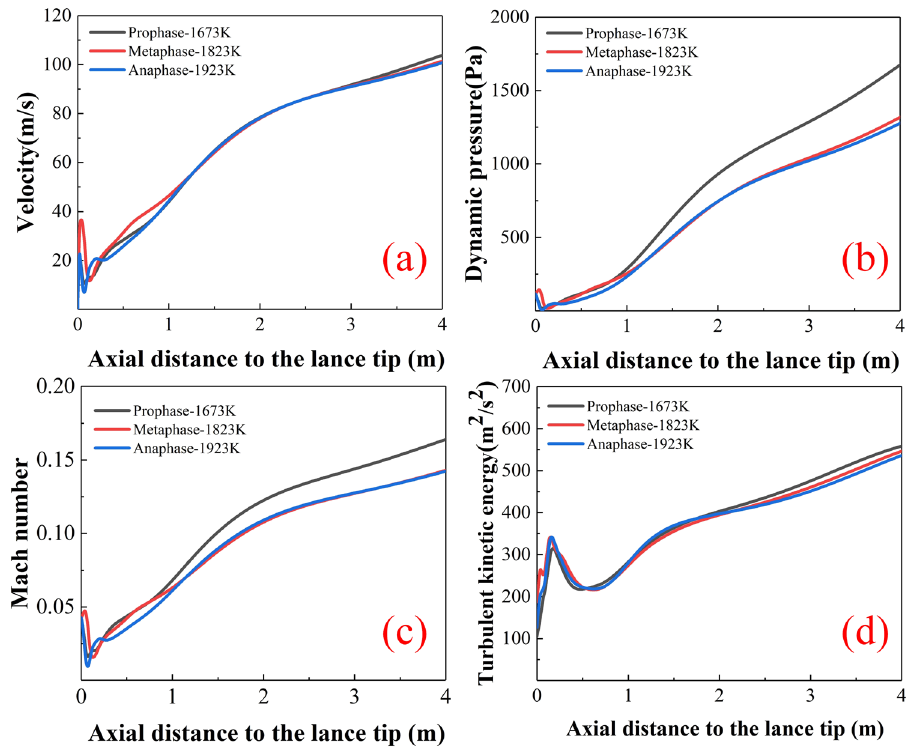
Figure 13: Jet characteristics of the nozzle centerline for di ff erent smelting periods: ( a ) velocity, ( b ) dynamic pressure, ( c ) Mach number, and ( d ) turbulent kinetic energy.